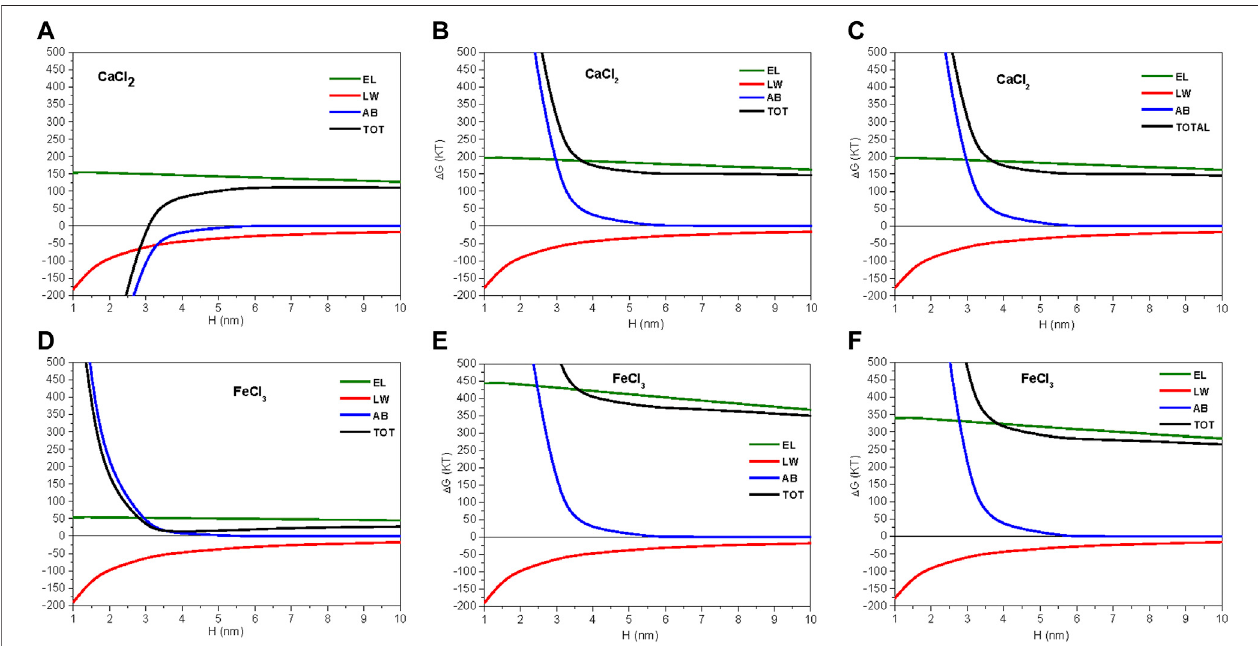
FIGURE 5 | Components of total interaction energy at the soil pH: (A) forest sample, 10 – 3 M CaCl 2 solution (pH 6.47); (B) organic sample, 10 – 3 M CaCl 2 solution (pH6.44); (C) conventional sample, 10 – 3 M CaCl 2 (pH 6.17); (D) forest sample, 10 – 3 M FeCl 3 solution (pH 6.47) (E) organic sample, 10 – 3 M FeCl 3 solution (pH 6.44); (F) conventional sample, 10 – 3 M FeCl 3 solution (pH 6.17). TOT, total energy; EL, electrostatic component; AB, acid – base component; LW, Lifshitz – van der Waals component.